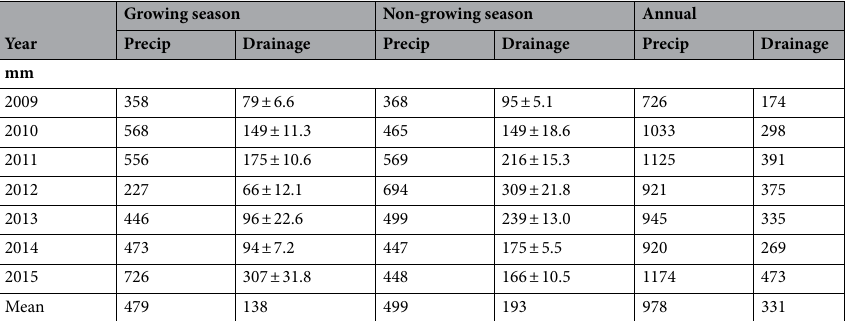
Table 2. Precipitation (precip, mm) and mean modeled drainage (mm) by growing season (May–Sep) and non-growing season (Oct–Apr). Annual precipitation is given for the approximate crop-year periods (May– April). Drainage data are the mean ± s.e. of across all six cropping system systems, which were not statistically